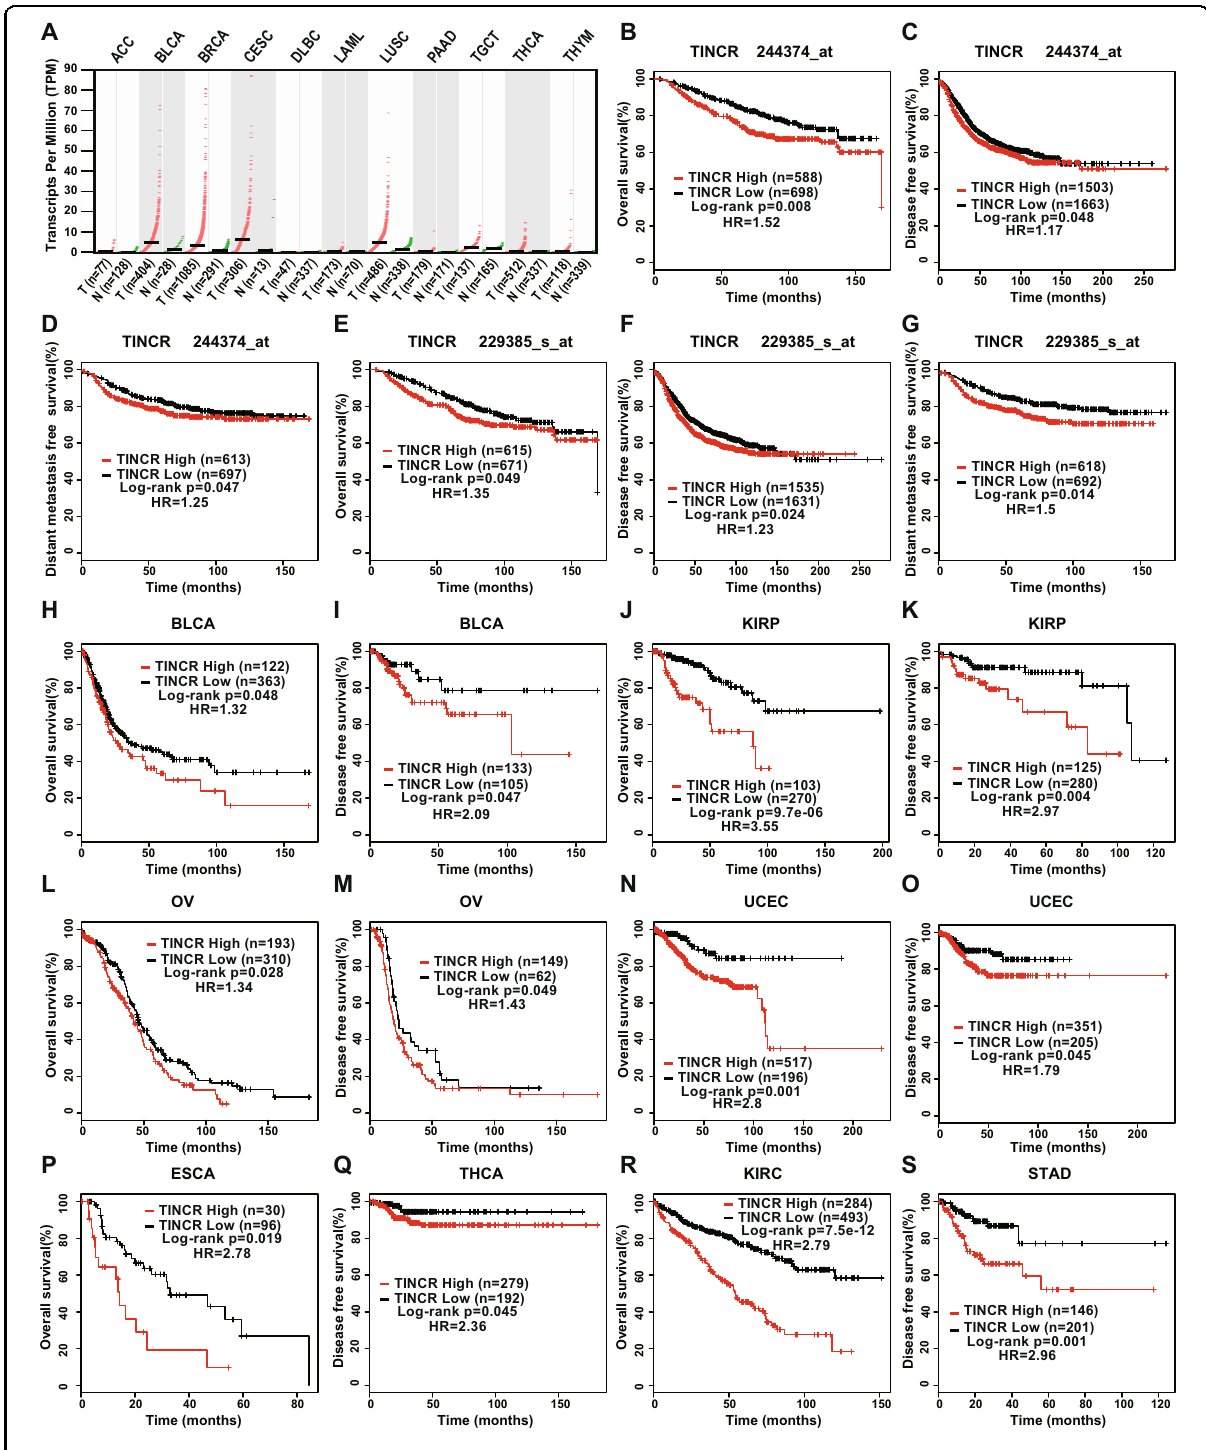
Fig. 2 High expression of TINCR is correlated with poor prognosis in human cancer. a Scatter diagram depicting TINCR expression in multiple cancer and adjacent normal tissues, generated from GEPIA database. b – g Kaplan – Meier analysis of OS ( b , e ), DFS ( c , f ), and DMFS ( d , g ) of breast- cancer patients according to TINCR expression, generated from GEO database. h – s Kaplan – Meier analysis of OS and DFS in BLCA ( h , i ), KIRP ( j , k ), OV ( l , m ), UCEC ( n , o ), ESCA ( p ), THCA ( q ), KIRC ( r ), and STAD ( s ) patients according to TINCR expression, generated from TCGA database. Data are shown as means ± standard deviation (SD); Student ’ s t test, * P < 0.05, ** P < 0.01, *** P < 0.001, **** P <